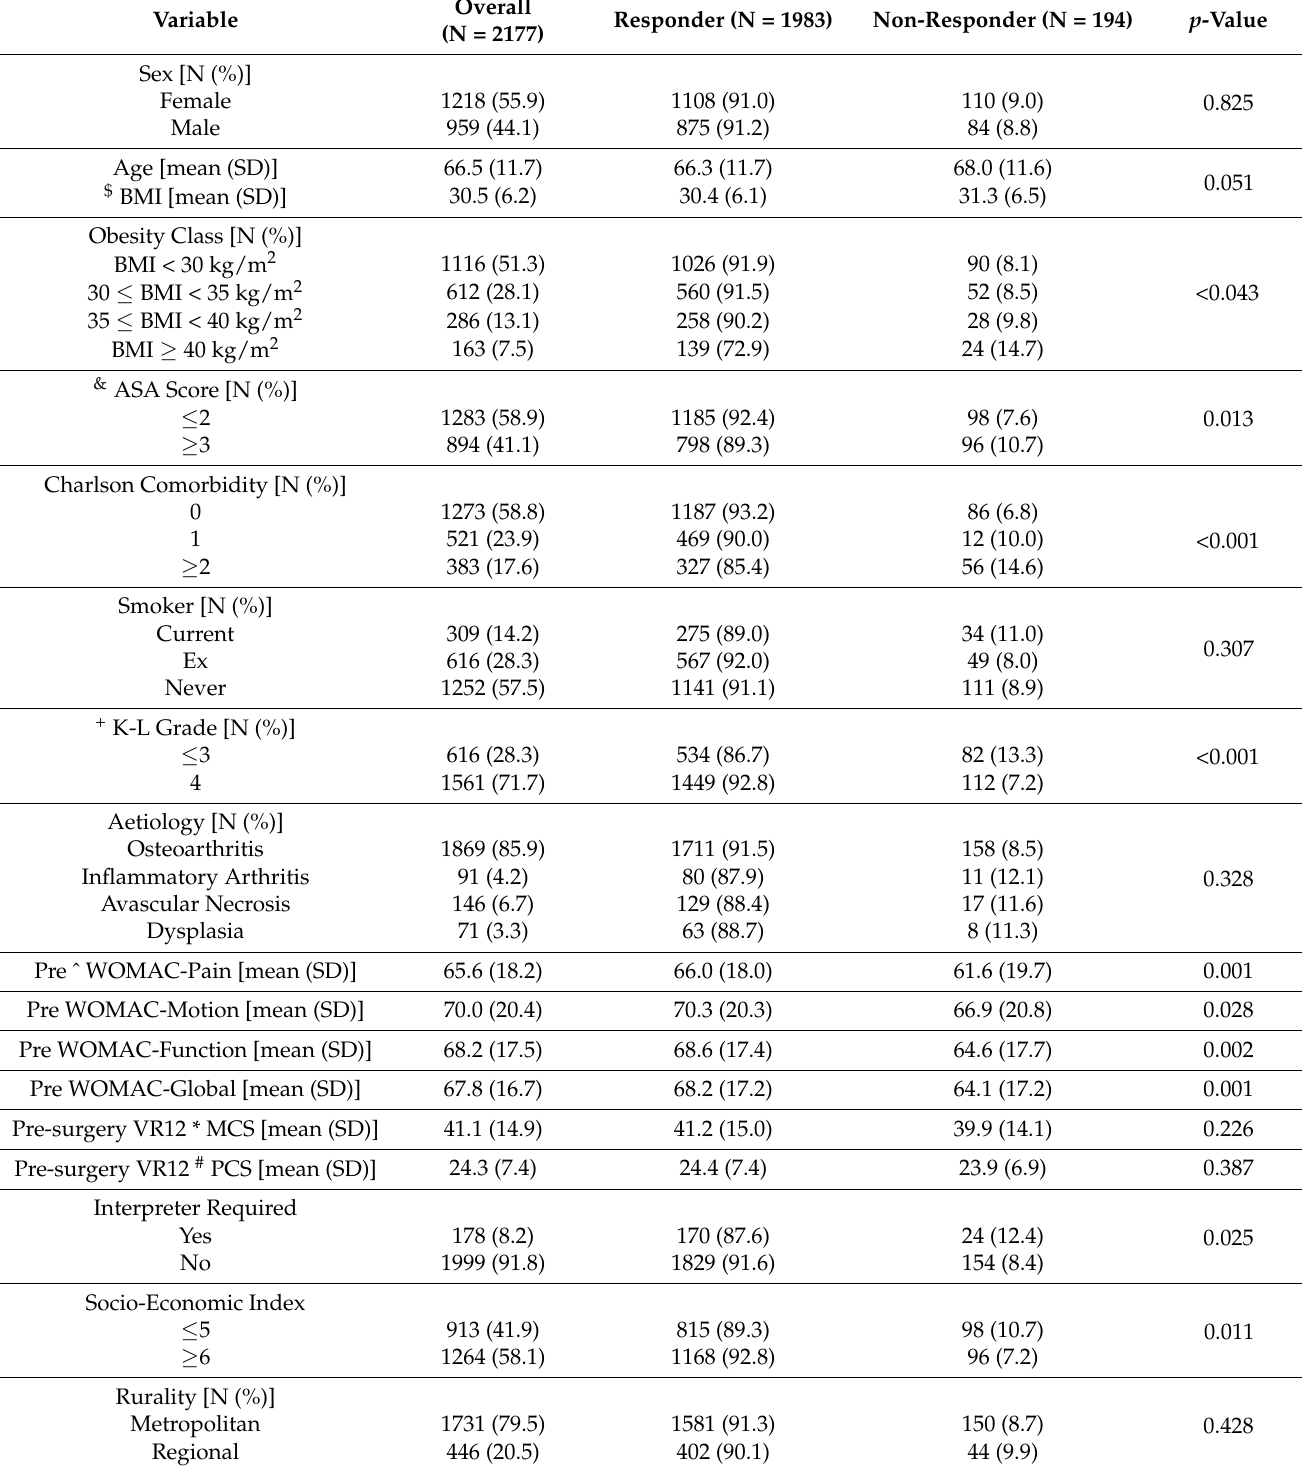
Table 1. Baseline patient demographics and